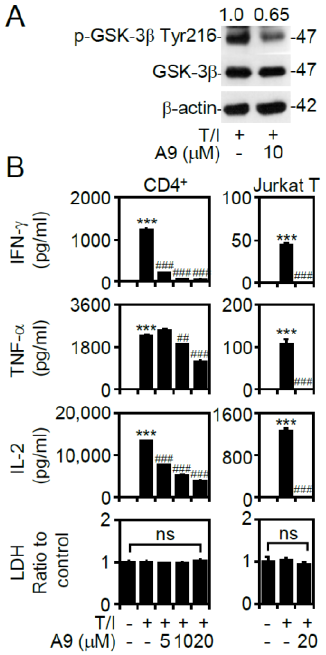
Figure 3. Treatment with T / I induces Pyk-2-regulated GSK-3 β activation and cytokine production. ( A ) Western blotting detected the phosphorylation of GSK-3 β (47 kDa) in CD4 + lymphocytes treated with the T / I combination in the presence of A9 (10 µ M). ( B ) ELISA determined the levels of cytokines in the cell supernatants of T / I-treated CD4 + T lymphocytes and Jurkat T cells 6 h posttreatment after A9 pretreatment for 0.5 h. For Western blotting, β -actin (42 kDa) was used as an internal control. The ratio of phosphorylated protein / total protein / β -actin is shown. For ELISA, an LDH assay was used to detect cell cytotoxicity, and the results are normalized to the untreated group. The data are shown as the mean ± SD from three individual experiments. *** p < 0.001 compared to the untreated cells. ## p < 0.01 and ### p < 0.001 compared to the T / I-treated group. ns, not significant.